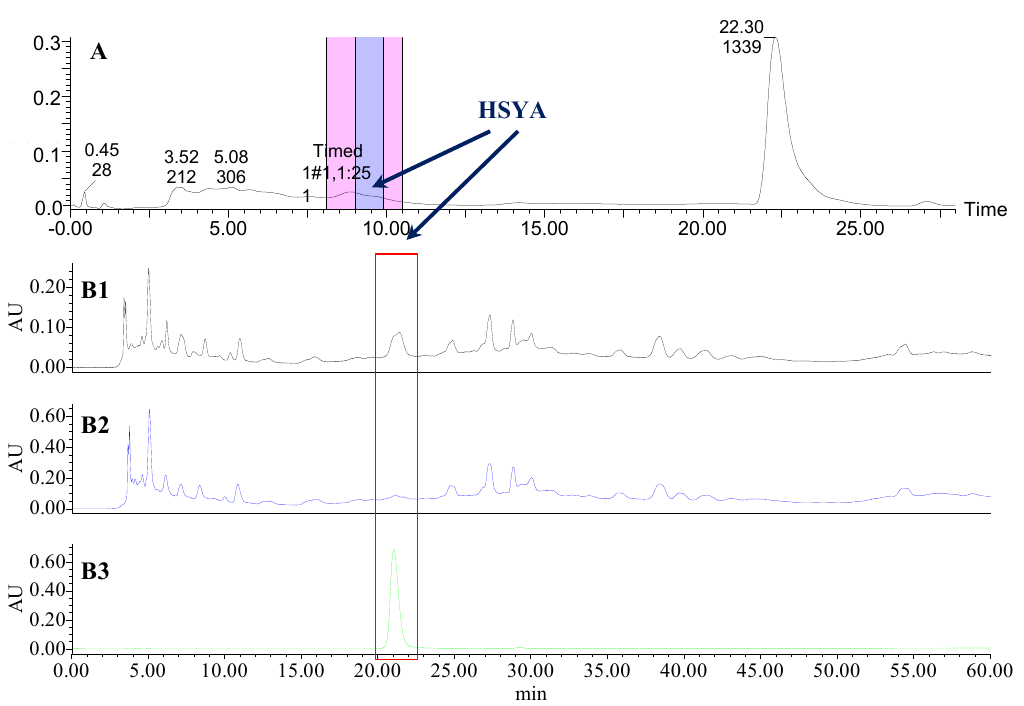
Figure 2. The preparative and analytical chromatograms of the depletion of HSYA from CF; ( A ) preparative chromatogram at 270 nm; ( B1 ) analytical chromatogram of CF at 270 nm; ( B2 ) analytical chromatogram of CF-A at 270 nm; ( B3 ) analytical chromatogram of HSYA depleted from CF at 270 nm.